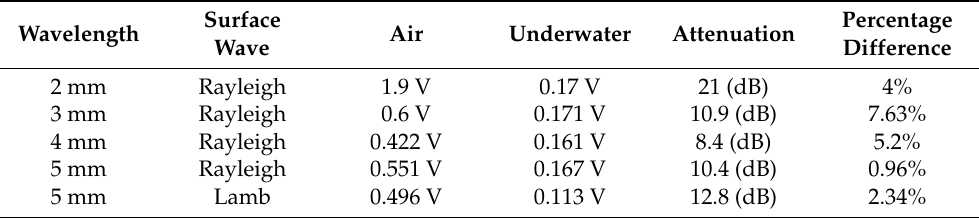
Table 2. COMSOL Simulation Peak to Peak Value and Attenuation.